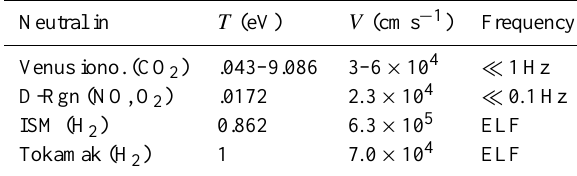
Table 1. Justification of assumption (f) of Sect.